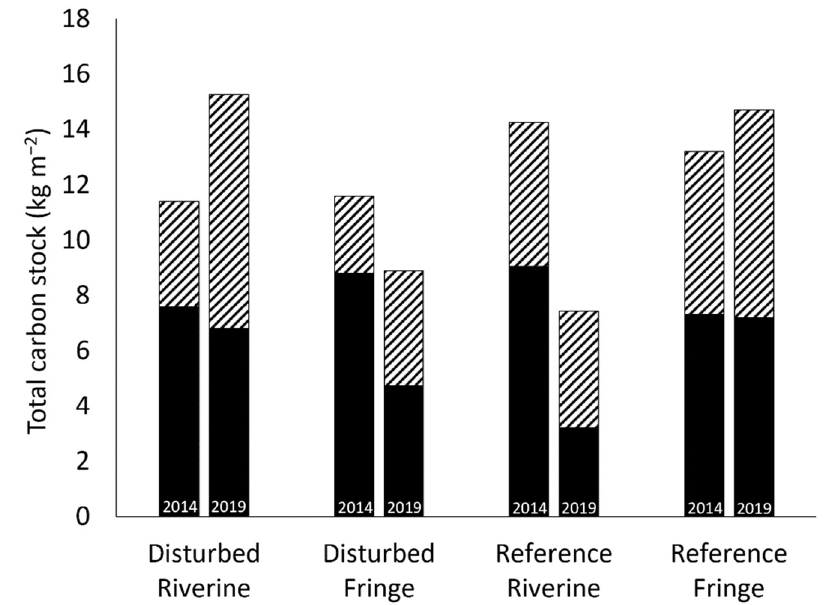
Figure 7. Total carbon stock in aboveground (grey stripes) and belowground (solid black) stores in the two hydrogeomorphic settings (fringe and riverine) in the hydrologically disturbed and reference creeks in the period 2013–2014 and 2019.